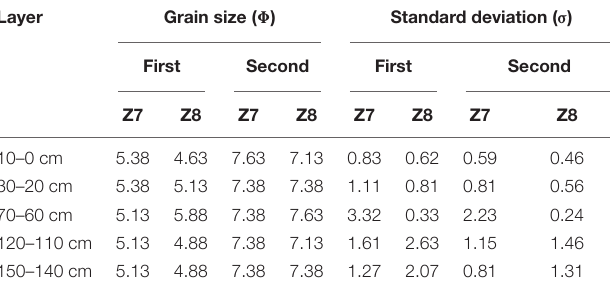
TABLE 2 | Grain size and peak heights of the sensitive grain size fraction of the selected